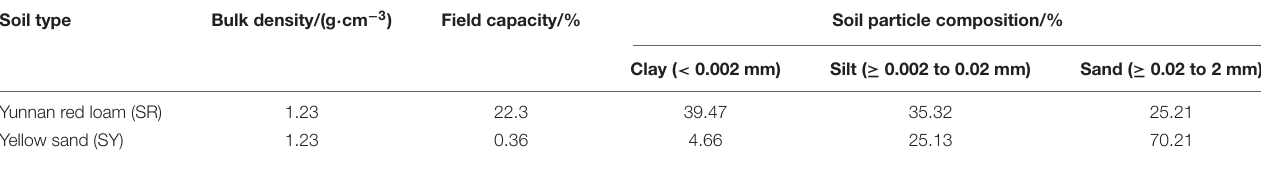
TABLE 1 | Physical properties of Yunnan laterite and yellow sand soil. Soil